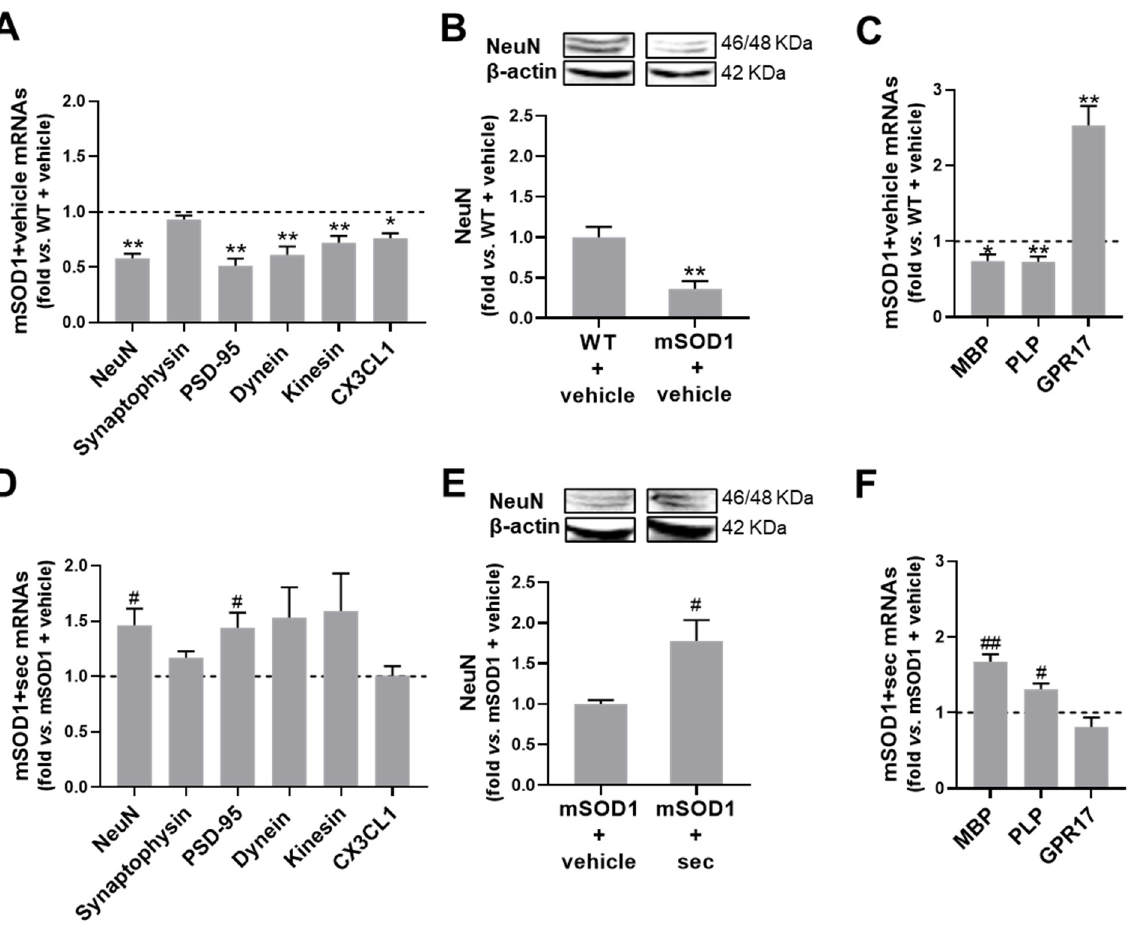
Figure 7. Neuronal demise and deficits in synaptic signalling, axonal transport, CX3CL1-CX3CR1 axis, and myelination in the lumbar spinal cord (SC) of 15-week-old mSOD1 mice are prevented by the intrathecal injection of the secretome from modulated mSOD1 motor neurons (MNs) in 12- week-old animals. ( A ) Gene expression of neuronal-related NeuN, synaptophysin, PSD-95, dynein, kinesin, and CX3CL1; ( B ) protein expression of NeuN; and ( C ) myelin-associated genes (MBP, PLP, and GPR17) in the SC of 15-week-old SOD1-G93A (mSOD1) mice that were treated with the vehicle (basal media of NSC-34 MNs) at 12-week-old, in comparison with the respective wild-type